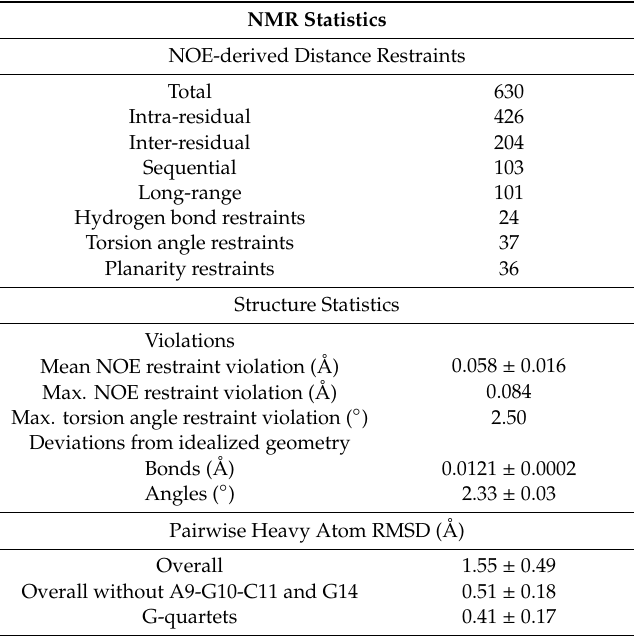
Table 1. NMR and structure